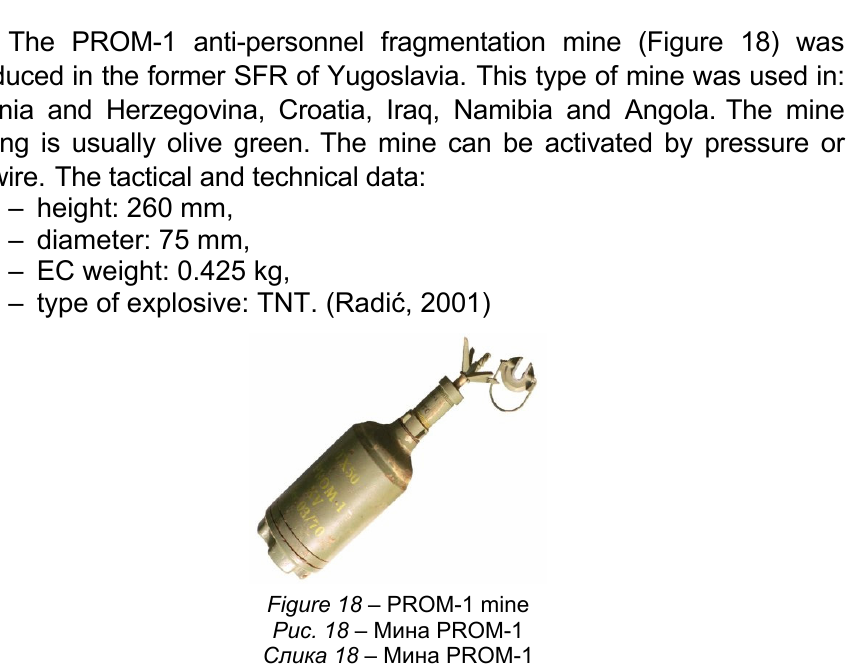
Figure 17 – Mine POZM-2 Рис . 17 – Мина POZM-2 Слика 17 – Мина POZM-2